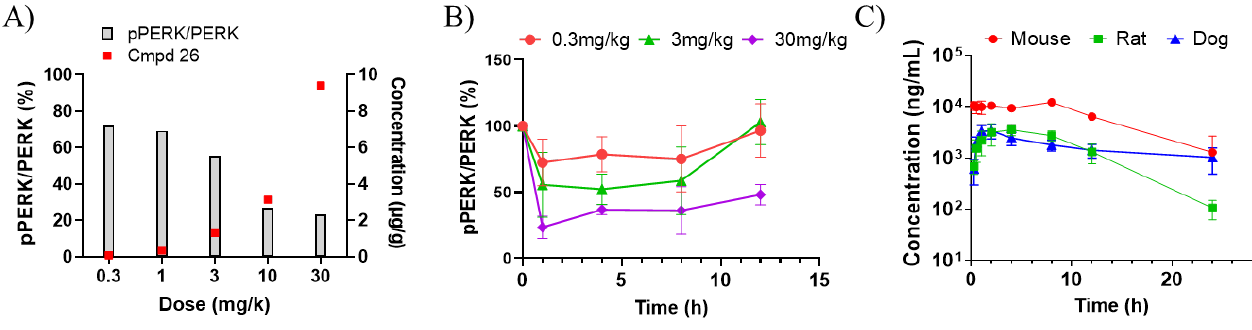
Figure 5. In vivo PK/PD analysis of 26 . ( A ) Inhibition of pPERK relative to total PERK protein (pPERK/PERK) in pancreas following oral administration of 26 . Abundance of 26 quantified by LC-MS/MS from matching pancreas samples at Cmax (1 h post administration). ( B ) Inhibition of pPERK/PERK in pancreas following oral administration of 26 at 0.3, 3, or 30 mg/kg. Pancreas samples taken at 1, 4, 8, 12 h following oral administration of 26 . Data represent mean ± SD of four mice. ( C ) Plasma PK analysis of 26 in mouse, rat and dog. 26 administered orally at 10 mg/kg, and sampled across a 24-h period; 26 quantified by LC-MS/MS.